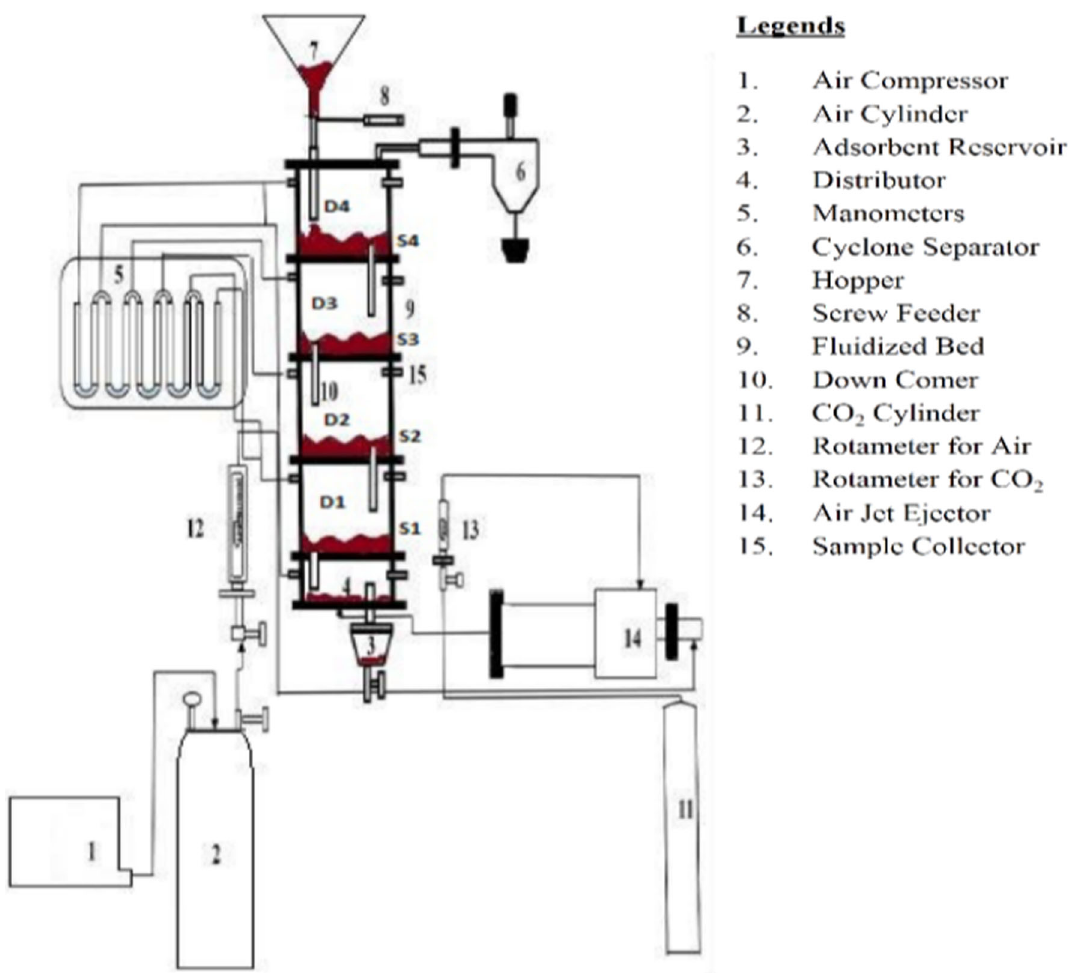
Fig. 1 Schematic diagram of the experimental set-up of a four stage counter-current fluidized bed